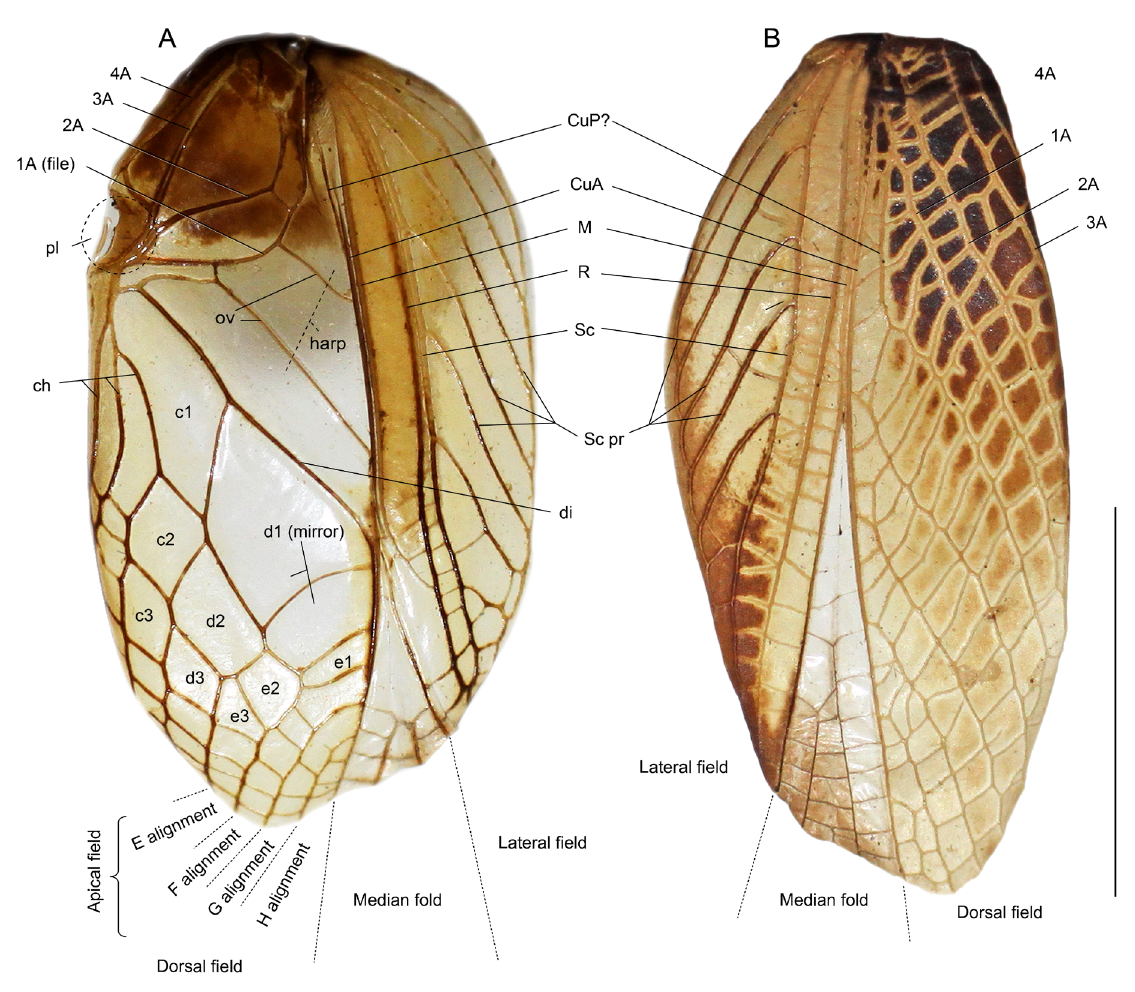
Fig. 3. Forewing venations (with labels of the veins and areas) of Nisitrus vittatus (Haan, 1844). A . ♂. B . ♀. Scale bar = 5